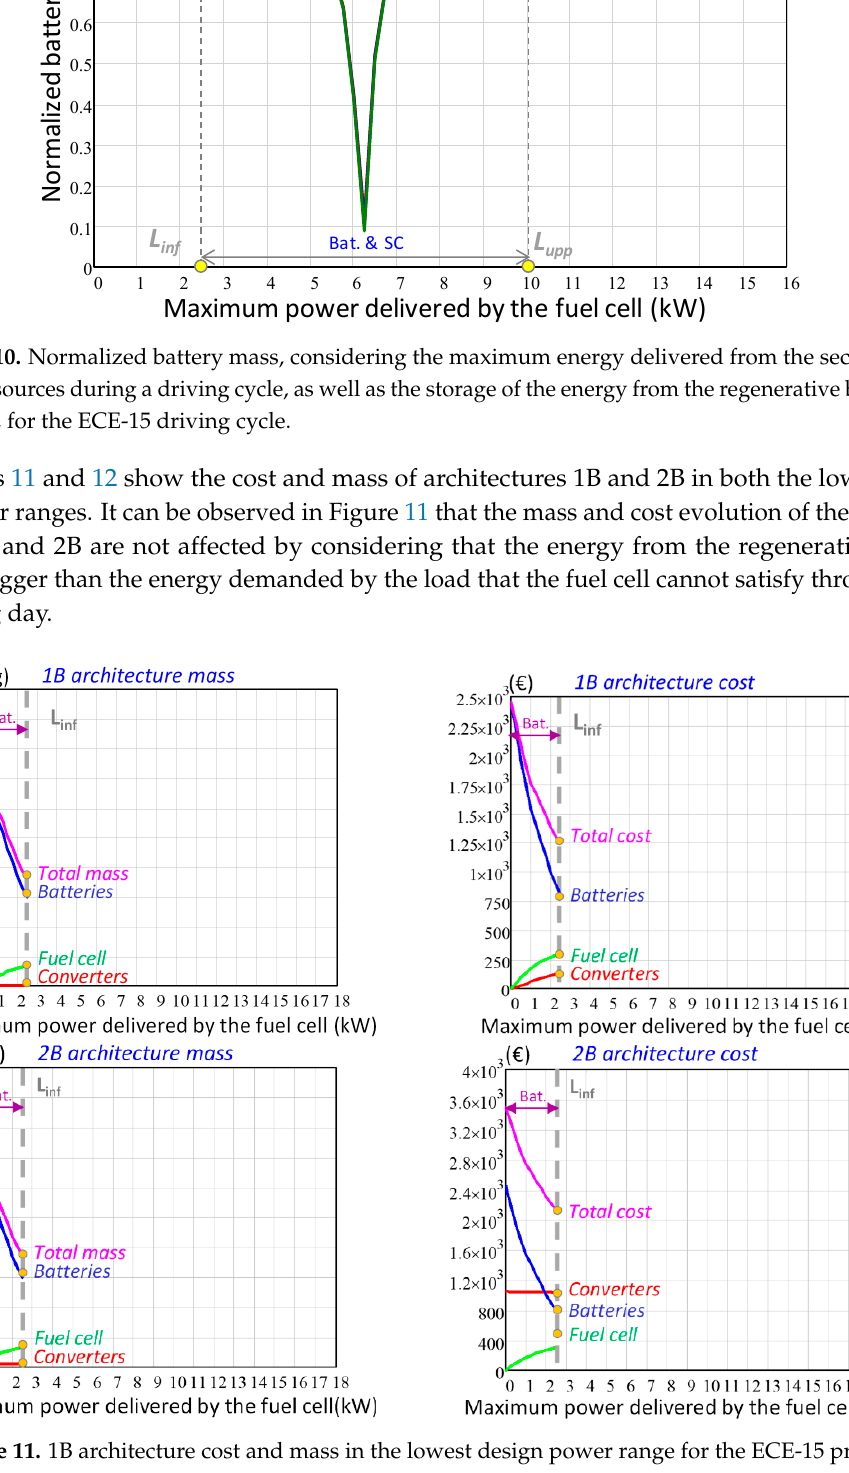
Figure 11. 1B architecture cost and mass in the lowest design power range for the ECE-15 profile.